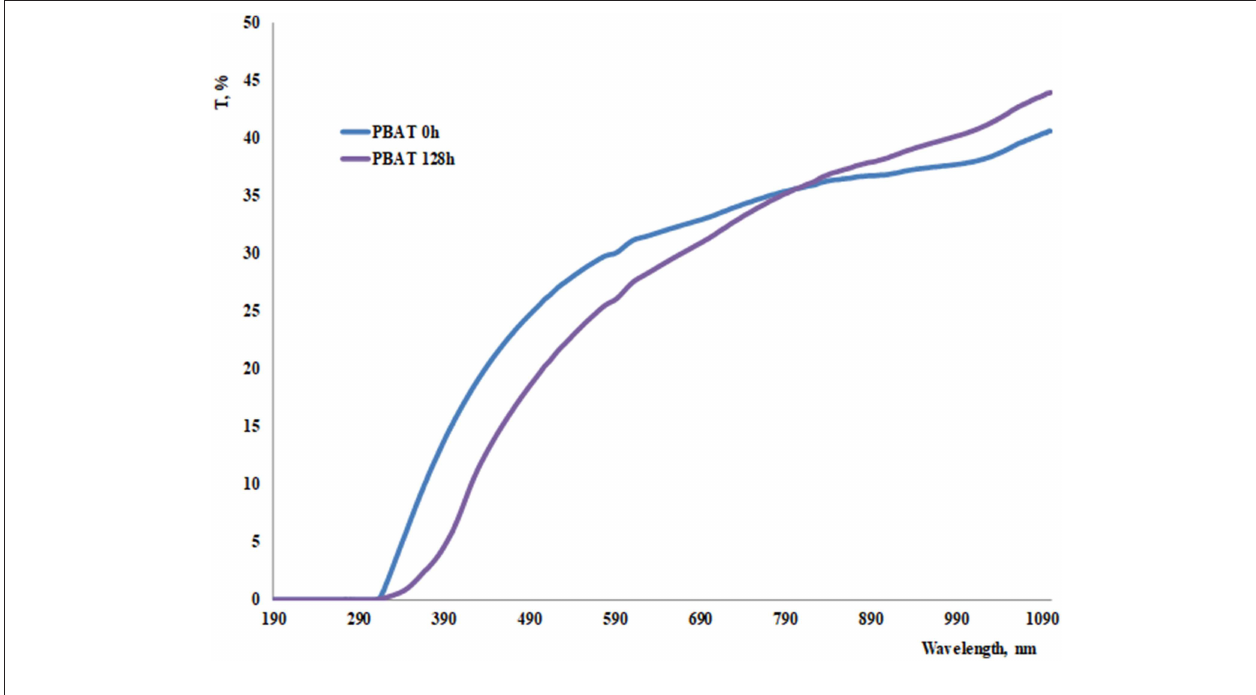
FIGURE 11 | UV spectra of pristine and 128 h-irradiated PBAT.